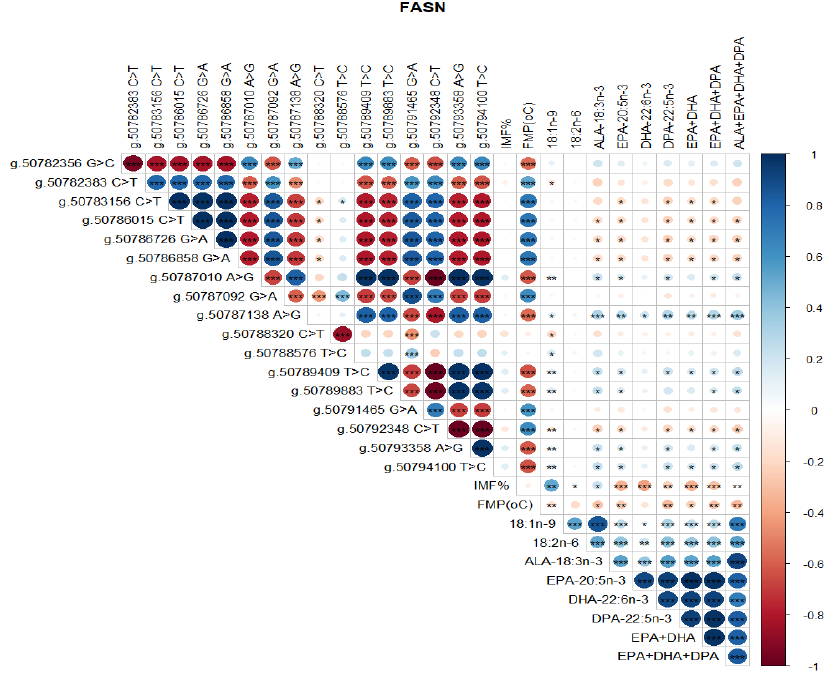
Figure 5. Spearman’s correlations between FASN gene SNP loci, IMF, FMP, and fatty acid profiles of Bowen Genetics Forest Pastoral Angus, Hereford, and Wagyu beef cattle breeds. (* p < 0.05, ** p < 0.01; *** p < 0.001). Dark blue indicates a strong positive relationship, and dark red shows a strong negative